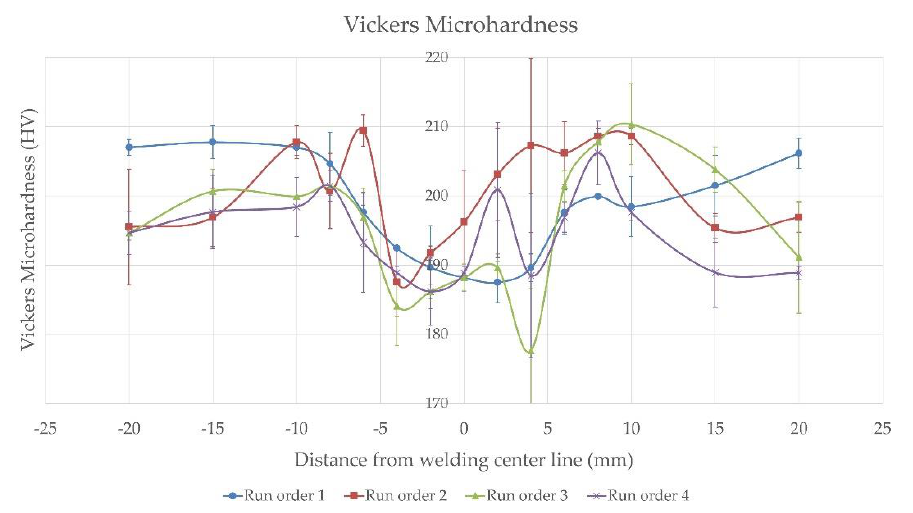
Figure 16. Vickers microhardness results according to the experimental design.